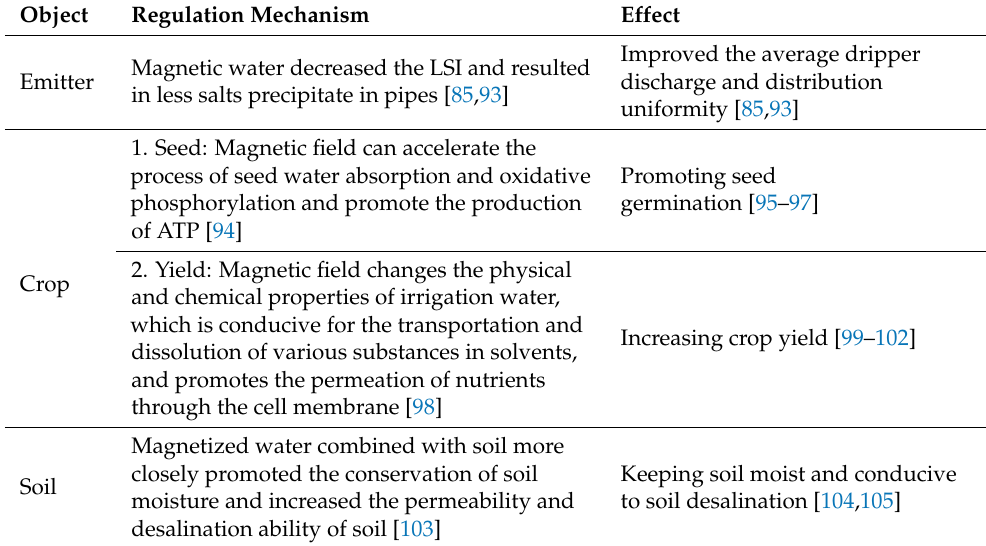
Table 6. Regulation mechanism and effect of magnetized water in agricultural